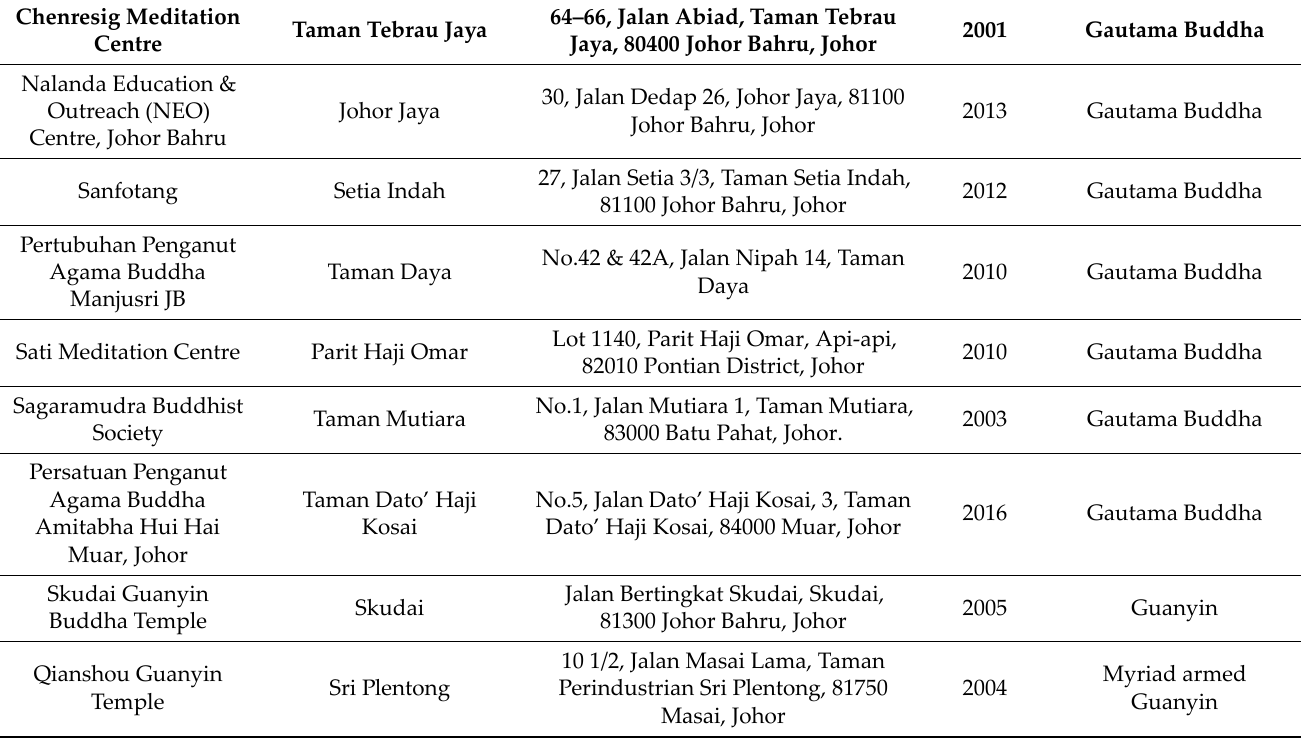
Table 15. Temple Dedicated To Buddhist Deity That Established in 21st